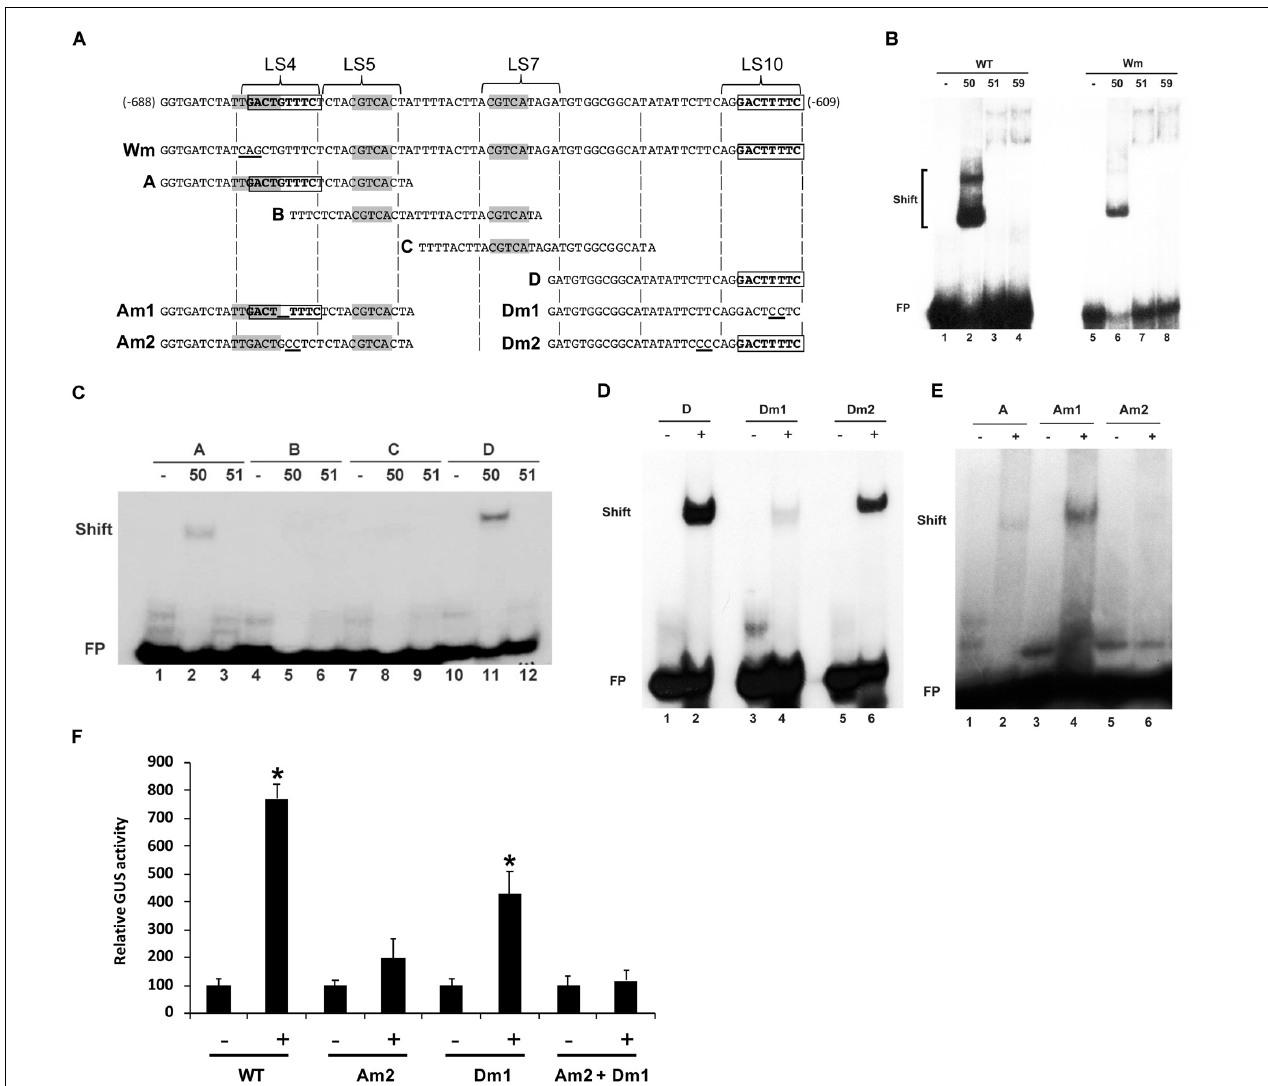
FIGURE 4 | Characterization of AtWRKY50’s binding sites on the PR1 promoter (A) Sequences of PR1 promoter fragments used for EMSAs. Only the sequence of the upper strand is given. The top line displays the sequence of the 80-bp fragment corresponding to bp –688 to –609 upstream of the transcription start site. Regions LS4, LS5, LS7, and LS10, as used in the linker scanning analysis of Lebel et al. (1998), are indicated. Wm indicates an 80-bp fragment with a mutation (TTGACT to TCAGCT) in the W-box in LS4. Overlapping subfragments A, B, C, and D, and their mutant versions Am1, Am2, Dm1 and Dm2 are aligned with the sequence of the 80-bp fragment. The W-box (TTGACT) and the CGTCA boxes of the as-1 element are indicated in bold. Mutations in Wm, Am1, Am2, Dm1, and Dm2 are underlined. (B) EMSAs were performed with wild type 80-bp PR1 promoter fragment (WT) or with an 80-bp fragment with a mutation in the W-box (Wm) as probes together with the GST-tagged C-terminal halves of AtWRKY50, -51 and -59, as indicated above the lanes. The positions of band shifts and the unbound probe (FP) are indicated. Lanes labeled with the minus sign were loaded with probe only. (C) AtWRKY50 binds to the PR1 promoter at two positions. EMSAs were performed with overlapping PR1 promoter fragments A, B, C, and D as probes and GST-tagged AtWRKY50-C or the C-terminal half of AtWRKY51, as indicated above the lanes. The positions of band shifts and the unbound probe (FP) are indicated. Lanes labeled with the minus sign were loaded with probe only. (D,E) AtWRKY50 binds to the LS10 and LS4 element in the PR1 promoter. EMSAs were performed with wild type (D) and WT (A) and mutant versions (Dm1, Dm2) of fragment D and Am1, Am2 of fragment A of PR1 promoter as probes and GST-tagged AtWRKY50-C, as indicated above the lanes. The positions of band shifts and the unbound probe (FP) are indicated. Lanes labeled with the minus sign were loaded with probe only; lanes labeled with the plus sign were loaded with the probe and AtWRKY50-C. (F) PR1 activation by AtWRKY50 requires intact binding sites. Arabidopsis protoplasts were co-transfected with WT and mutant PR1::GUS construct alone (minus sign) or together with expression plasmids 35S::AtWRKY50 . After incubation GUS activity was measured spectrophotometrically. Expression levels (%) are given relative to expression level without WRKY effector. Statistical differences among the samples is labeled with asterisk ( p <